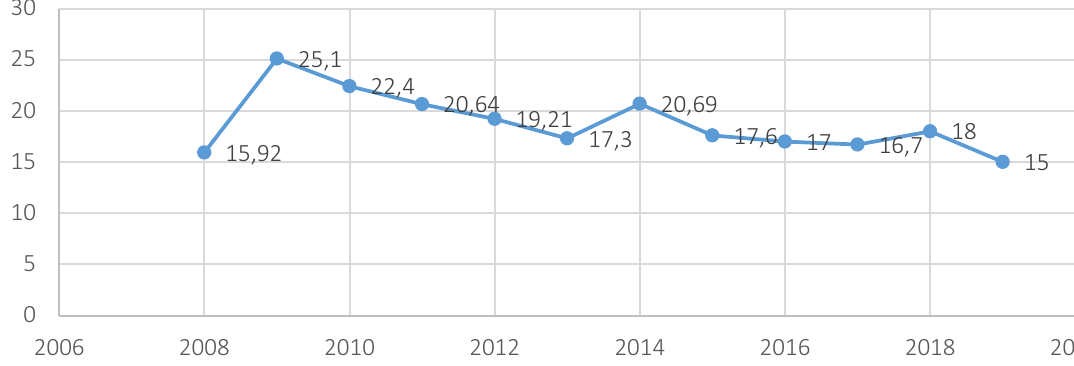
Figure 2. Share of tasks providing confidence in business entities in the financial sector, the total volume of services for 2008–2019,